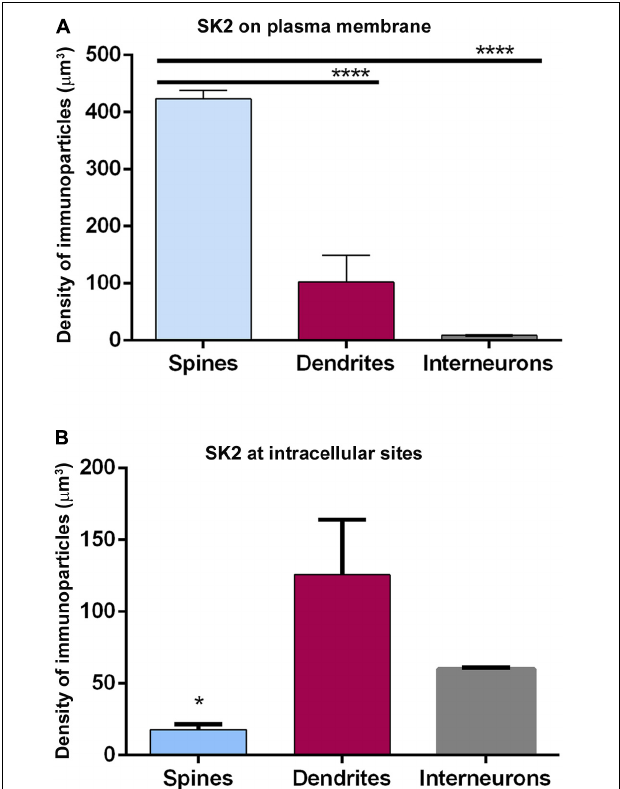
FIGURE 6 | Cell type-dependent density of SK2 channels. (A,B) Quantitative analysis showing comparative densities, measured as immunoparticles/ µ m 3 of SK2 immunoparticles along the plasma membrane (panel A ) and intracellular sites (panel B ) in the spines and shafts of pyramidal cells and interneurons. The density of plasma membrane SK2 on spines is 4 times higher than in shafts and 47 times higher than in interneurons. The density of intracellular SK2 immunolabelling at spines is 7-fold lower than in shafts and 3.5-fold lower than in interneurons (One-way ANOVA test and Bonferroni post hoc test, * p < 0.05, **** p < 0.0001). Error bars indicate